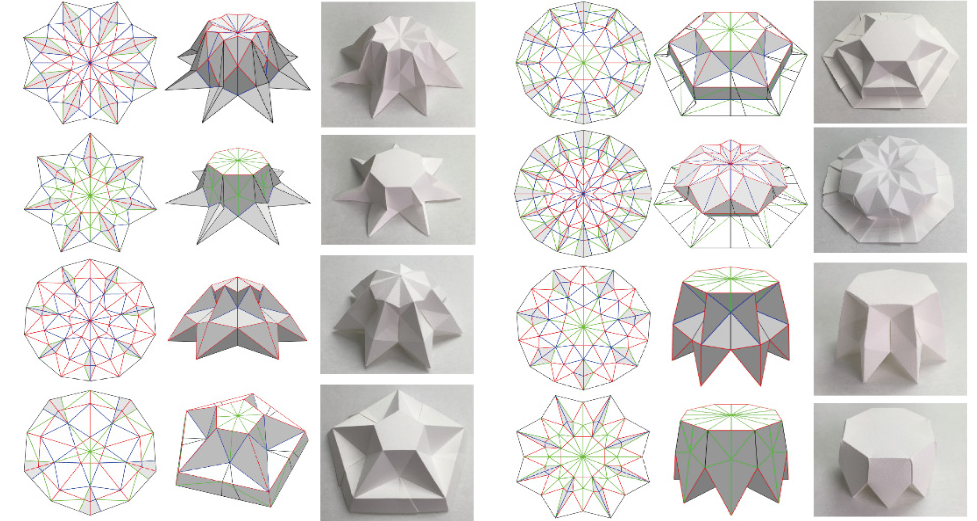
Figure 5. Example of origami patterns that can be used to construct the core of a sandwich panel. (image source: “Creative Commons Multifunctional resulting origami pieces with 3D flaps” by Zhao et al. https://doi.org/10.3390/sym10100469 (accessed on 18 August 2021), used under CC BY 4.0). Table 5. Sandwich structure with origami/foldcore.